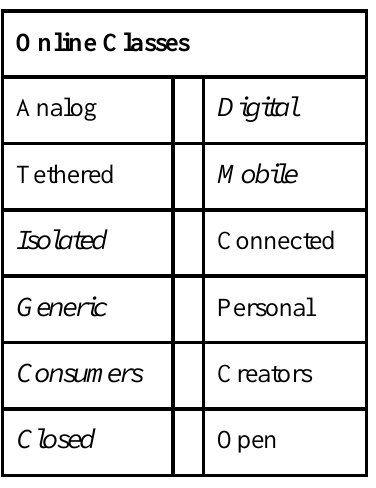
Characteristics of Online